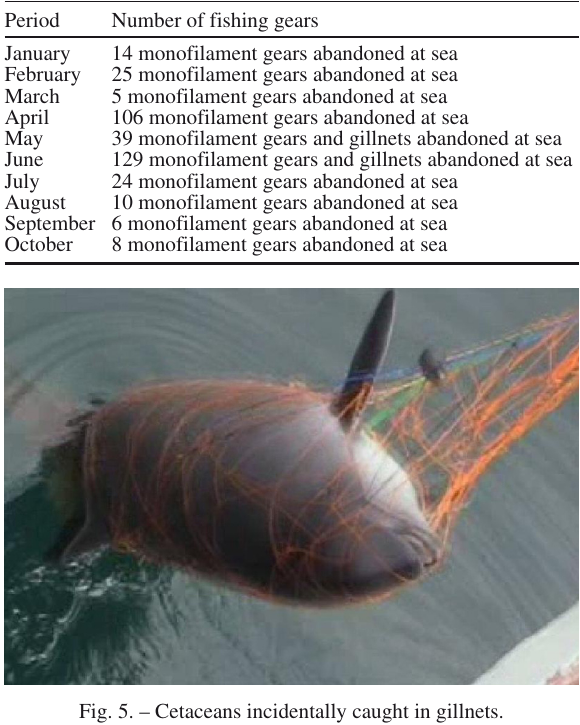
Table 4. – Abandoned gears in 2011.